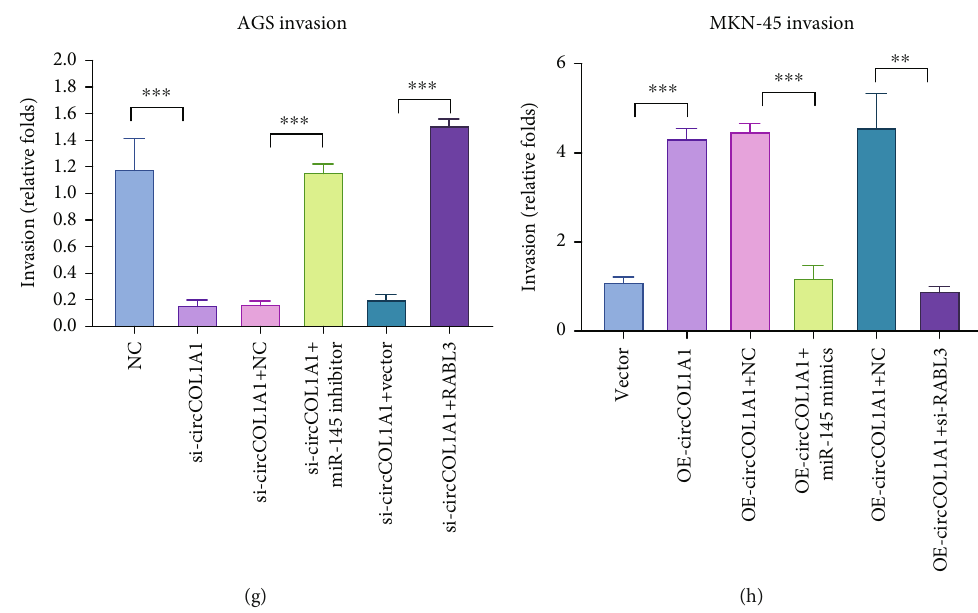
Figure 6: circCOL1A/miR-145/RABL3 axis regulates the proliferation, migration, and invasion of gastric cancer. (a) Western blot results of RABL3 in AGS cells. (b) Western blot results of RABL3 in MKN-45 cells. (c) CCK8 assay was used in AGS NC and si-circCOL1A1 cells. AGS NC and si-circCOL1A1 cells were rescued by transfection of the miR-145 inhibitor or RABL3 overexpression plasmids. (d) CCK8 assay was used in the MKN-45 vector and circCOL1A1 overexpression cells. MKN-45 vector and circCOL1A1 overexpression cells were then transfected with miR-145 mimics or RABL3 siRNA. (e) Migration assay was used in AGS NC and si-circCOL1A1 cells with indicated transfections. (f) Migration assay was used in the MKN-45 vector and circCOL1A1 overexpression cells with indicated transfections. (g) Invasion assay was used in AGS NC and si-circCOL1A1 cells with indicated transfections. (h) Invasion assay was used in the MKN-45 vector and circCOL1A1 overexpression cells with indicated